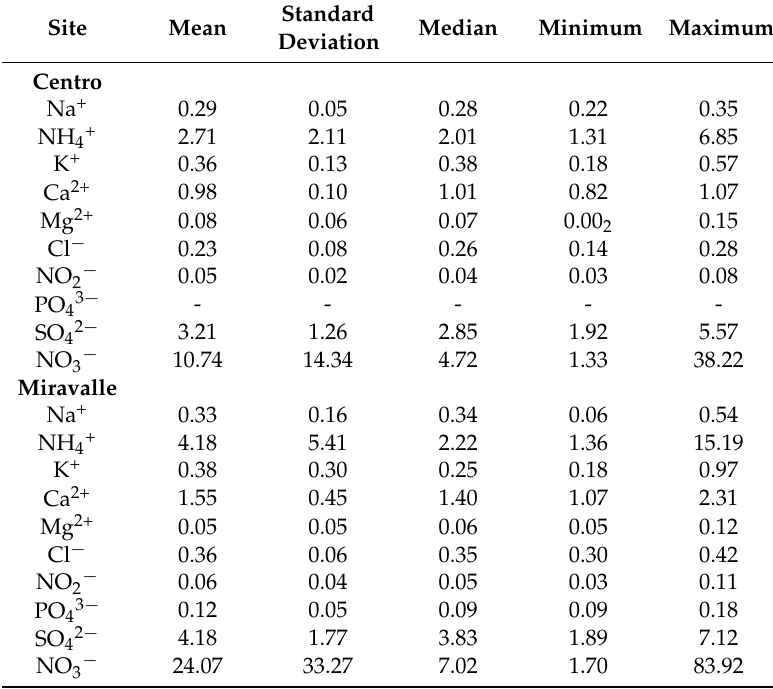
Table 3. Atmospheric concentrations ( µ g ¨ m ´ 3 ) for ionic